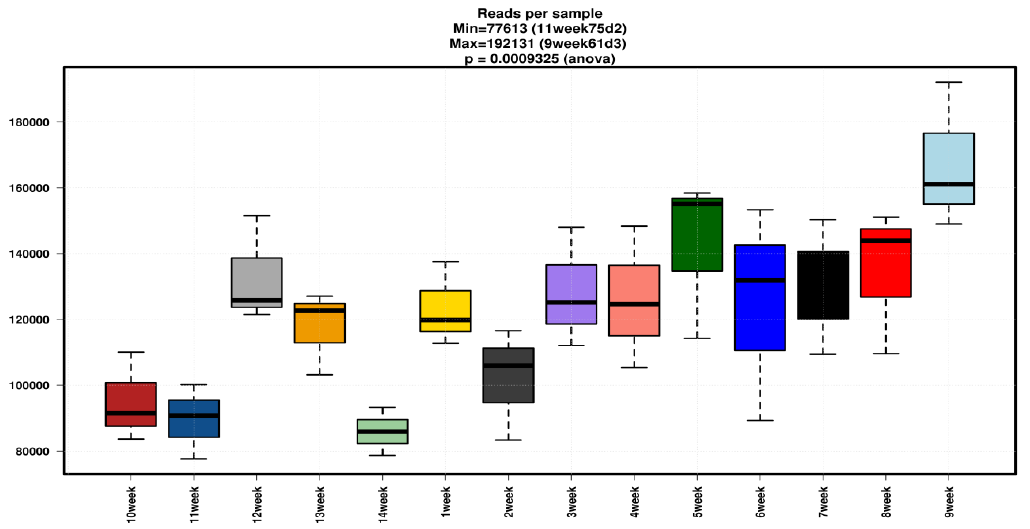
Figure 1. Boxplot of week wise sample showing the reads per sample of each group, X axis indicates the number of weeks and the Y axis indicates the number of reads. Different colors are just representing the differentiation among samples.